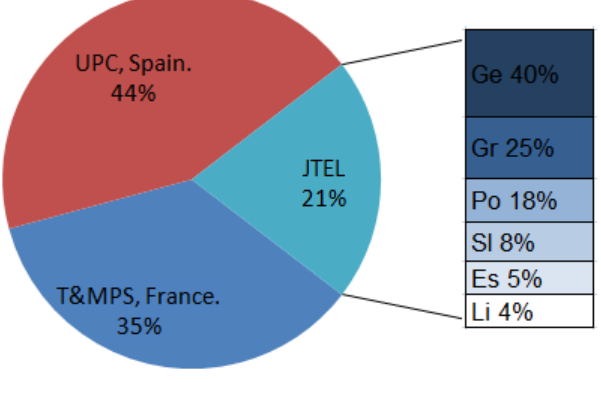
Figure 1. Geographic distribution of the survey results in percentage